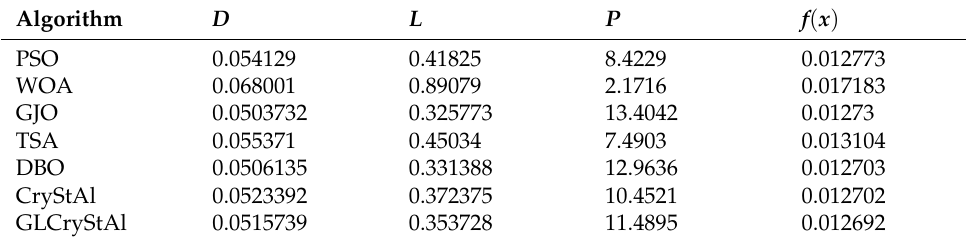
Table 11. The best results of six algorithms.